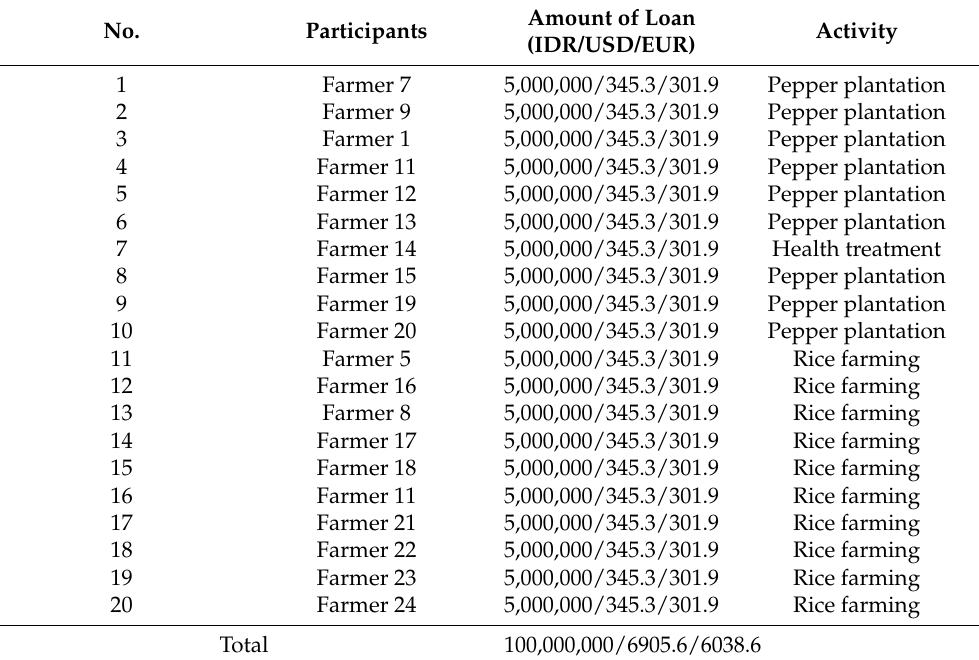
Table 7. Loan distribution among the Sumber Rejeki group 2018 (2018 rates USD 1 = IDR 14,481 and EUR 1 = IDR